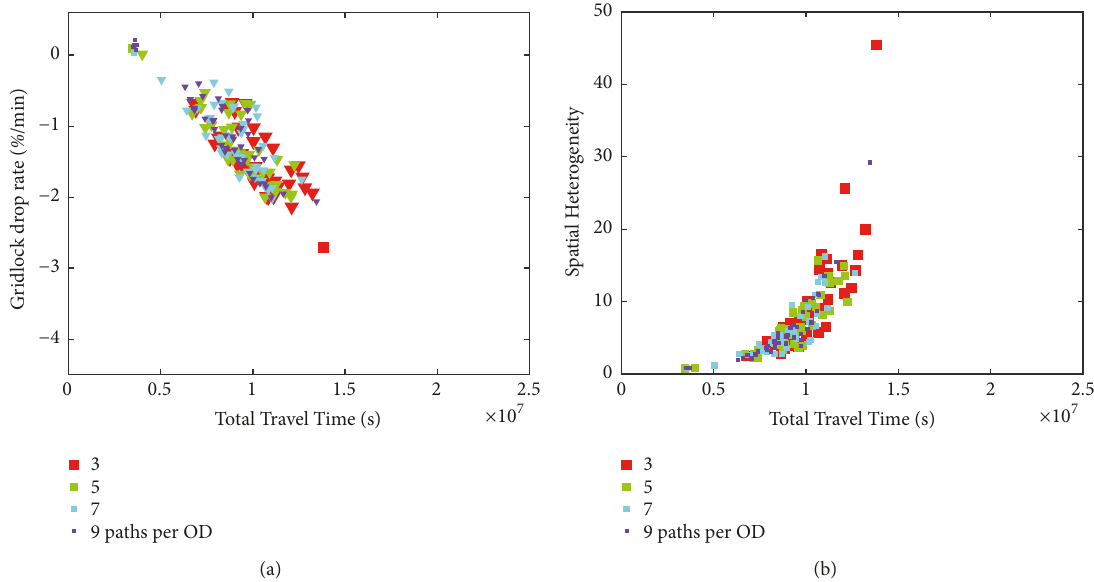
Figure 15: Network heterogeneities with demand level 5 and dynamic assignment, colored by number of paths per OD. (a) Gridlock drop rate and (b) spatial